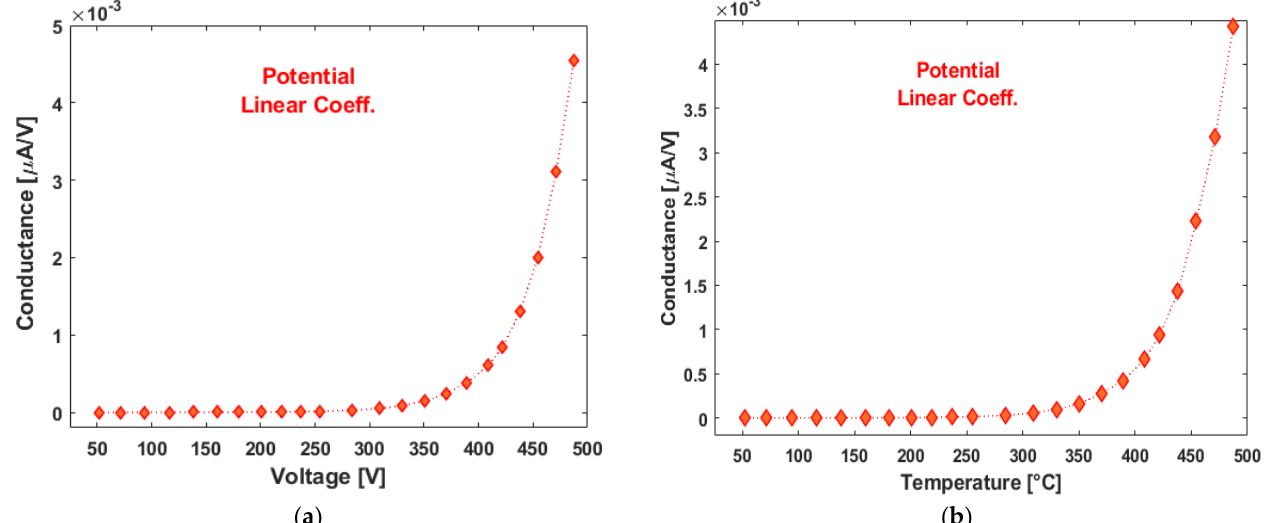
Figure A3. Linear conductance of BD sample as extracted by the I/V curves reported in Figures 4 and A1. ( a ) Extraction of sample conductance with V < 100 V for the first voltage ramp ( b ) Extraction of sample conductance with V < 100 V for the second voltage ramp with opposite